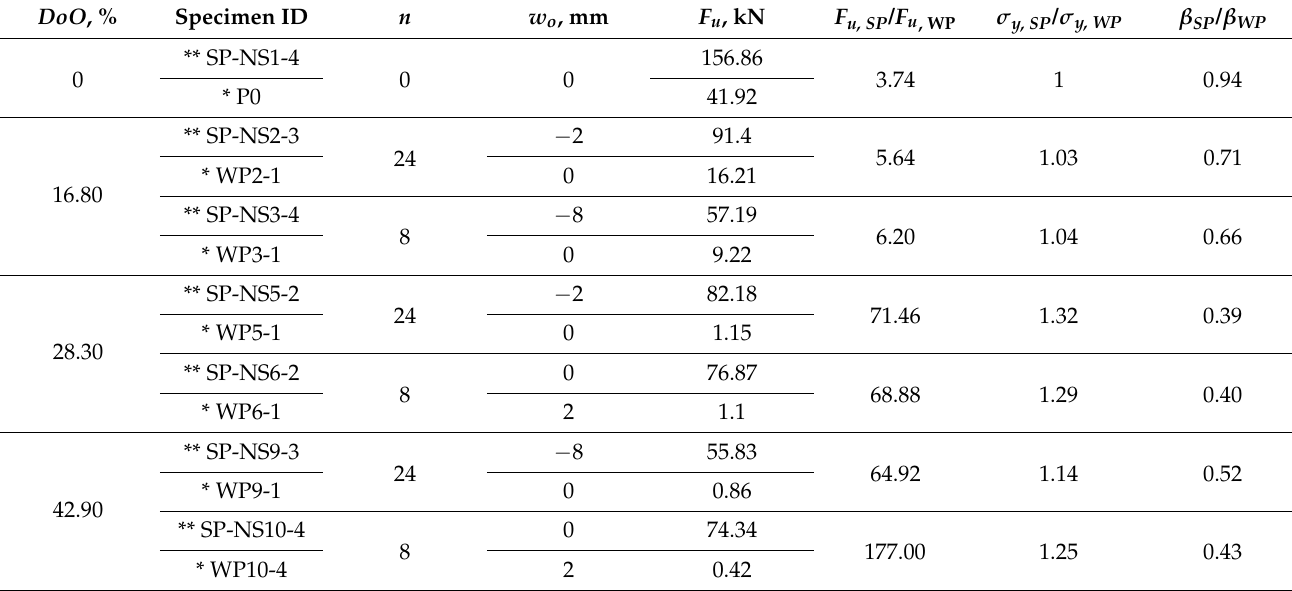
Table 4. Comparison between ** SP-NS and * WP-NS